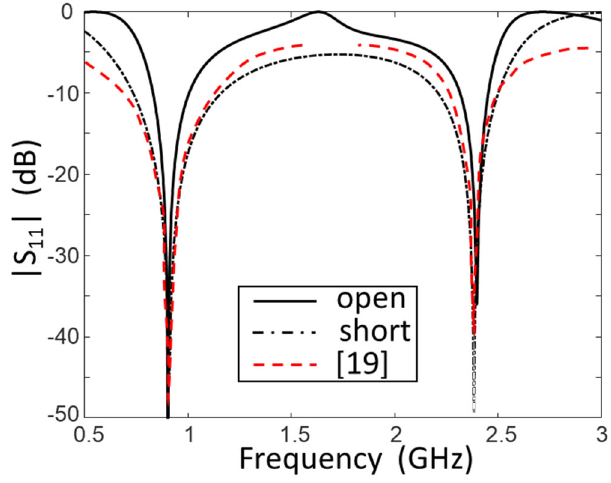
Figure 3. Comparison between the reflection coefficient obtained with two ‐ section networks (con ‐ tinuous black line) and that reported in the literature (dashed red line) for the case [19] in Table 1.